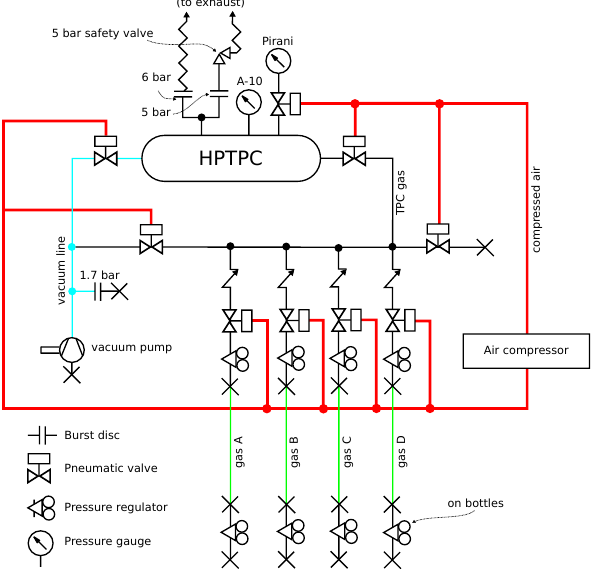
Figure 5. Diagram of the gas fill and evacuation system for the HPTPC vessel. The gas filling strategy for the HPTPC foresees evacuating (and purging) the vessel prior to the target gas fill. An Agilent Triscroll 800 dry vacuum pump is used to pump the vessel down to a pressure of approximately 1 × 10 − 6 barA before gas operations. The same pump is used to evacuate the fill line from the gas system to the vessel with the purpose of reducing contamination, either during the filling procedure or in case a gas fill is topped up to a higher pressure. The system enables the mixing of gases from four different inputs, using eight Aura gas pressure regulators with manometers and threaded connections (four in the primary 200 − 10 bar stage and four in the secondary 10 − 0